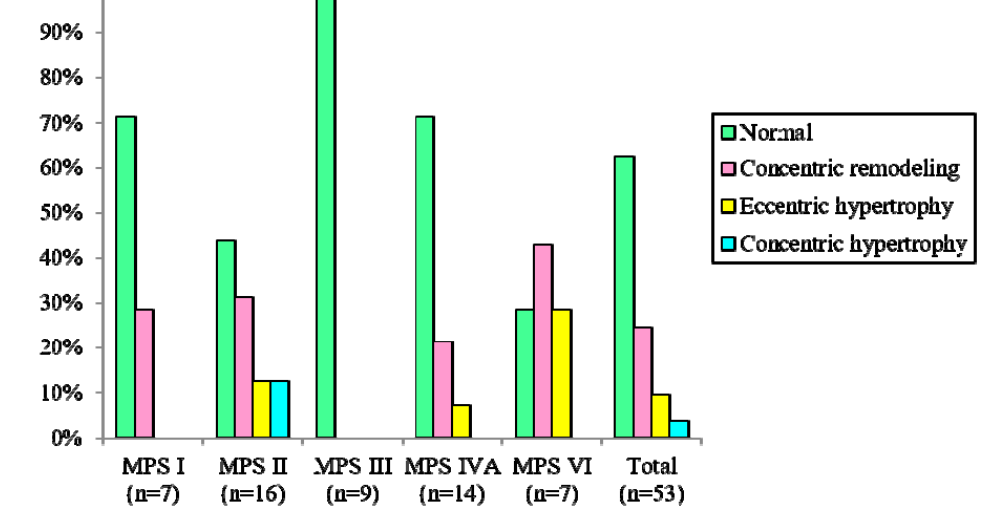
Figure 6. Percentages of left ventricular remodeling patterns in various MPS types. MPS, mucopolysaccharidosis.